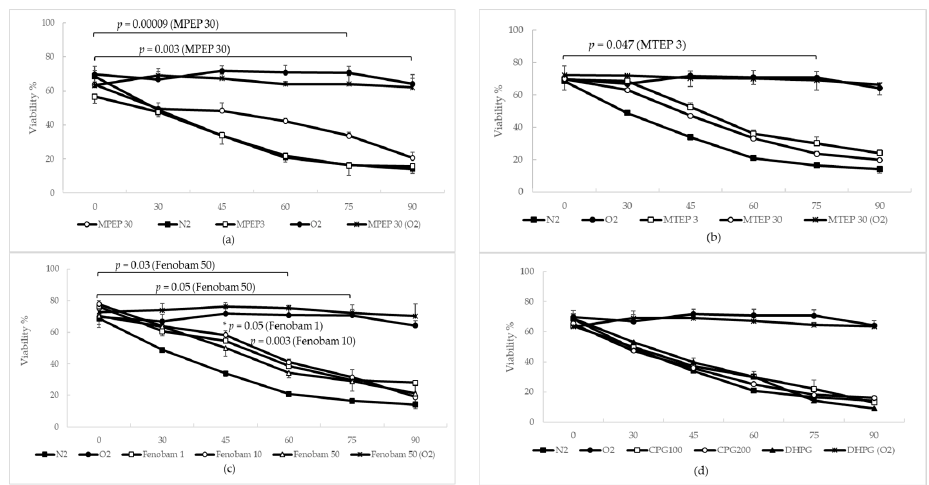
Figure 3. MPEP, MTEP and fenobam reduce mortality rate (measured by TB exclusion) of hypoxic primary hepatocytes. ( a ) The mortality rate of hepatocytes treated with MPEP 30 µM was lower than in control anoxic hepatocytes, in the 0 ′ –90 ′ time range ( p = 0.003, linear mixed-effects fitting analysis). The p value for this comparison increased in the 0 ′ –75 ′ range ( p = 0.00009, linear mixed-effects fitting analysis); ( b ) MTEP 3 µM reduced the mortality rate in this time range ( p = 0.048, linear mixed-effects fitting analysis); ( c ) fenobam improved viability of hypoxic hepatocytes in both the 0 ′ –60 ′ and 0 ′ –75 ′ time range ( p = 0.03 and 0.05, respectively, linear mixed-effects fitting analysis). Furthermore, fenobam 1 µM and 10 µM improved the vitality of hepatocytes at 45 ′ and 60 ′ ( p = 0.05 and 0.003, respectively, Tukey’s Test); ( d ) the orthosteric antagonist CPG showed no protective effect. The administration of DHPG 100 µM–DFB 10 µM did not worsen cellular injury.